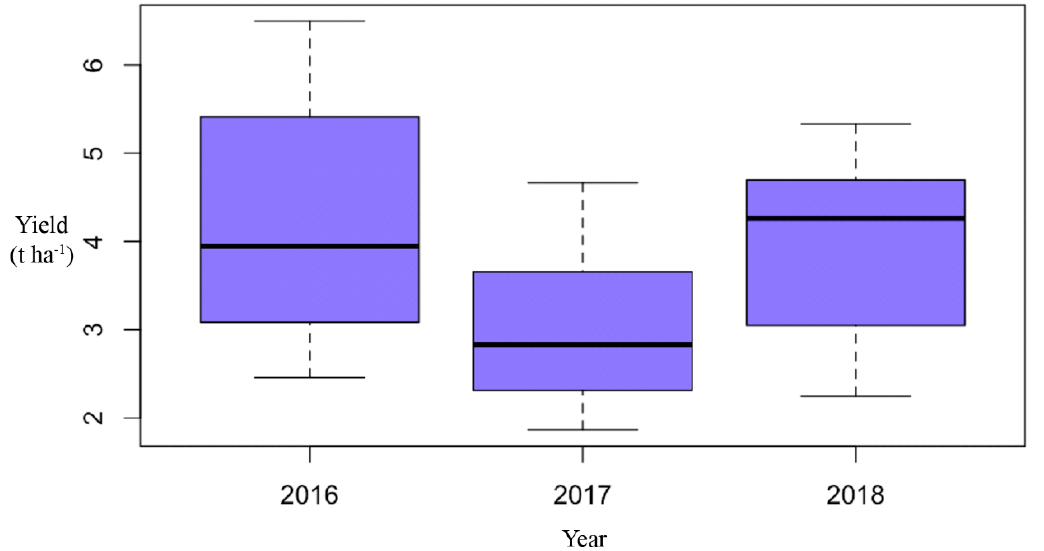
Figure 5. Yield values depending on the year.